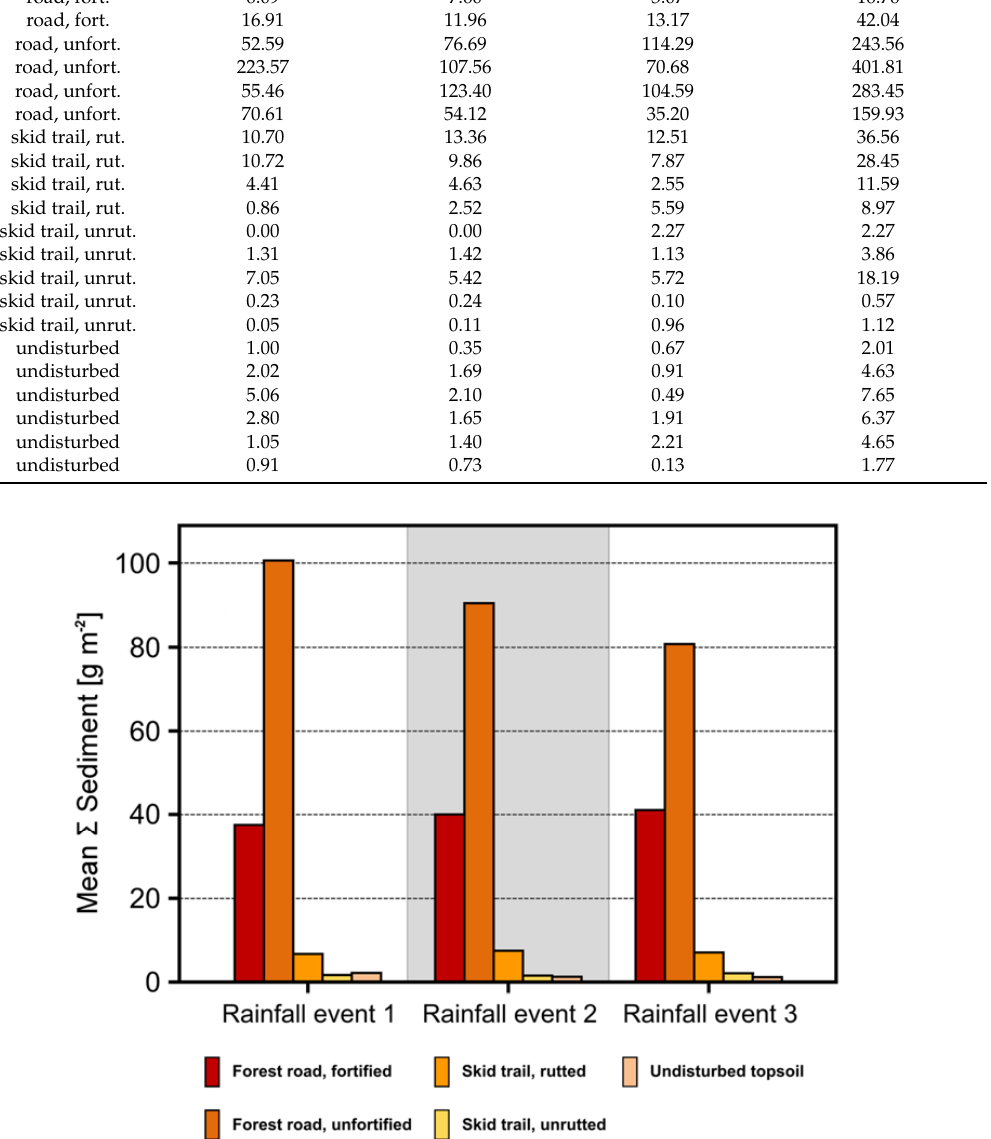
Figure 8. Mean sum of eroded sediment for each rainfall event, differentiated between surface Figure categories.